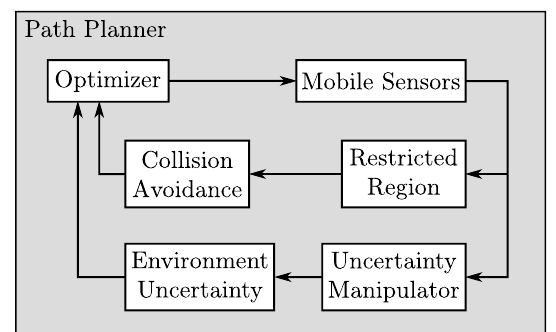
Figure 18: Block diagram for an optimization-based path planner for reducing uncertainty of (ice) environment while avoiding collisions. Courtesy: Joakim Haugen